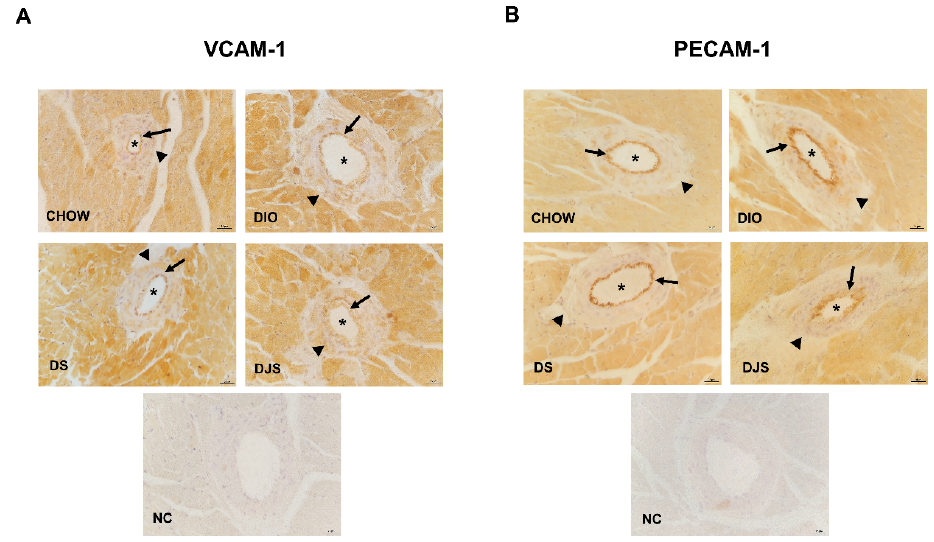
Figure 6. Immunohistochemical analysis of inflammatory adhesion molecules. Representative pictures of heart sections processed for the immunohistochemistry of vascular cell adhesion molecule-1 (VCAM-1) ( A ) and platelet endothelial cell adhesion molecule-1 (PECAM-1) ( B ). The immunoreaction is located in the endothelium (arrows) while the tunica media (arrowheads) is negative. The lumen of vessels is marked with an asterisk (*). Magnification 40×. Scale bar 25 µm. NC, Negative control. CHOW rats ( n = 8), fed with standard diet; DIO rats ( n = 9), fed with high-fat diet; DS ( n = 12), DIO rats supplemented with tart cherry seeds; DJS ( n = 9), DS rats supplemented with tart cherry juice.